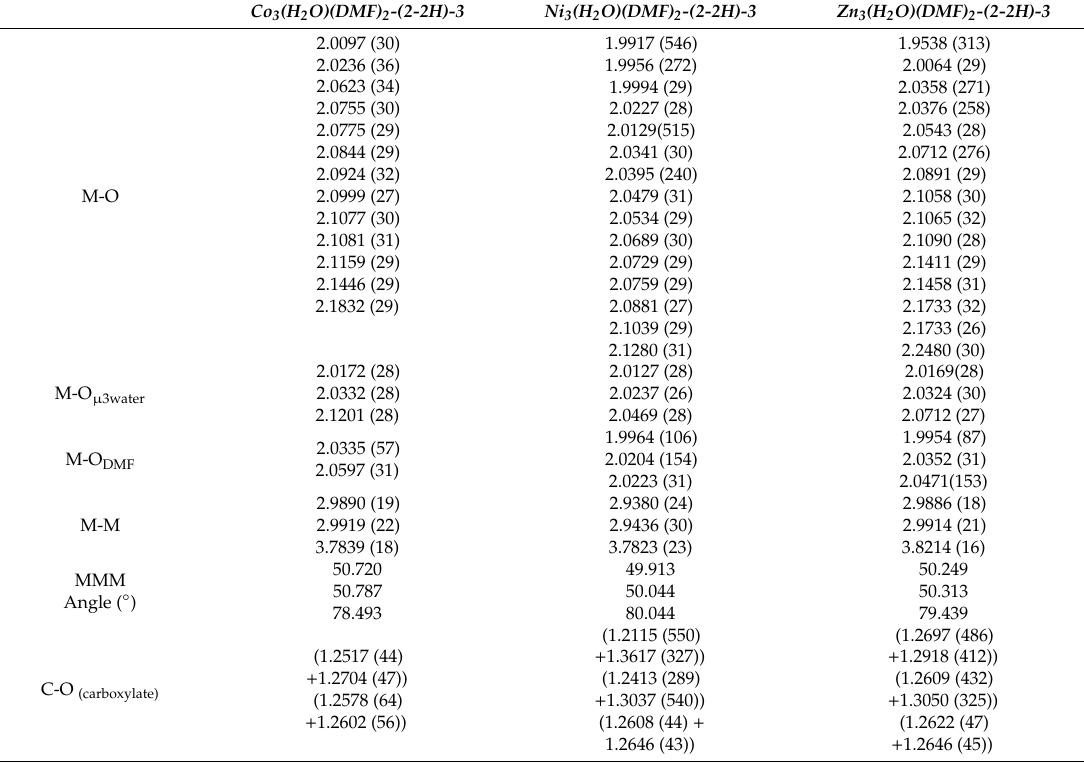
Table 2. The main distances for M 3 (H 2 O)(DMF) 2 -( 2 -2H)- 3 (M = Co II , Ni II and Zn II ) clusters.